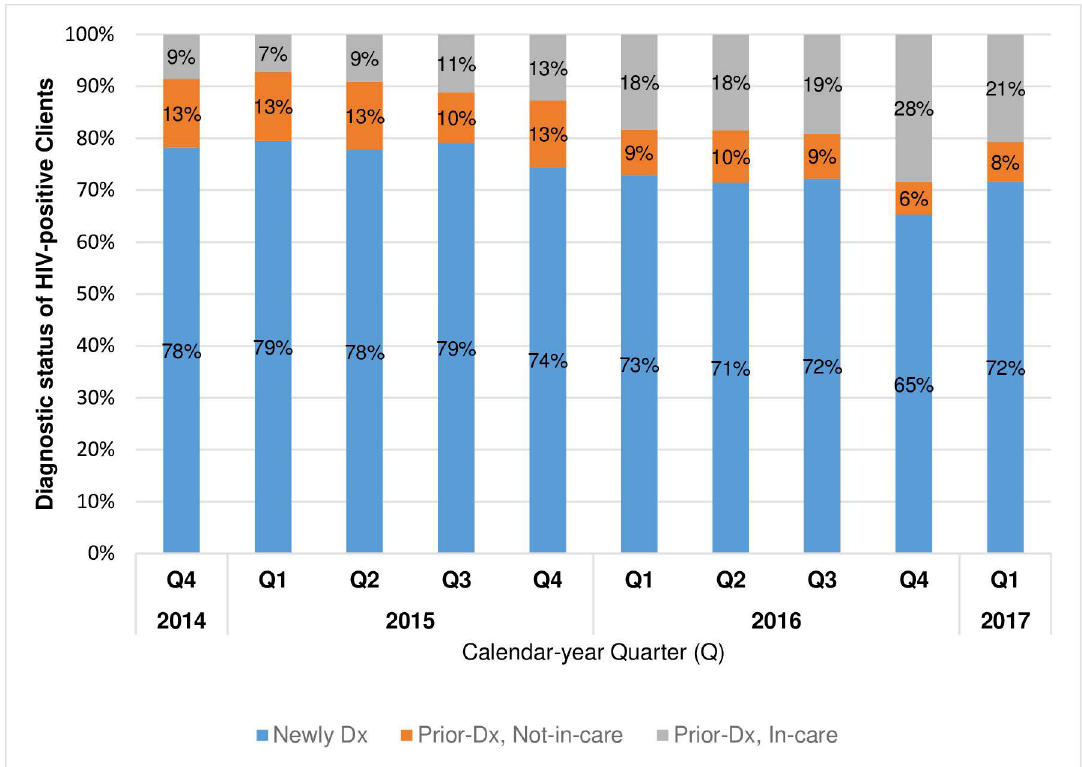
Fig 4. Distribution of diagnostic status of 5,550 HIV-positive clients, by calendar-year quarter, Bukoba Combination Prevention Evaluation, Bukoba Municipal Council, Tanzania, 2014-2017. a HIV, human immunodeficiency virus; Newly Dx, newly HIV diagnosed; Prior-Dx, Not-in-care, previously HIV diagnosed, has not received HIV care in the past 90 days; Prior-Dx, In-care, previously HIV diagnosed, has received HIV-care within the past 90 days. a All HIV-positive clients were screened to assess their new or prior diagnostic status. HIV-positive clients who reported having never previously tested HIV-positive were defined as newly HIV diagnosed. Range of HIV-positive clients by calendar-year quarter = 363 (Q1 2017)– 751 (Q1 2015).